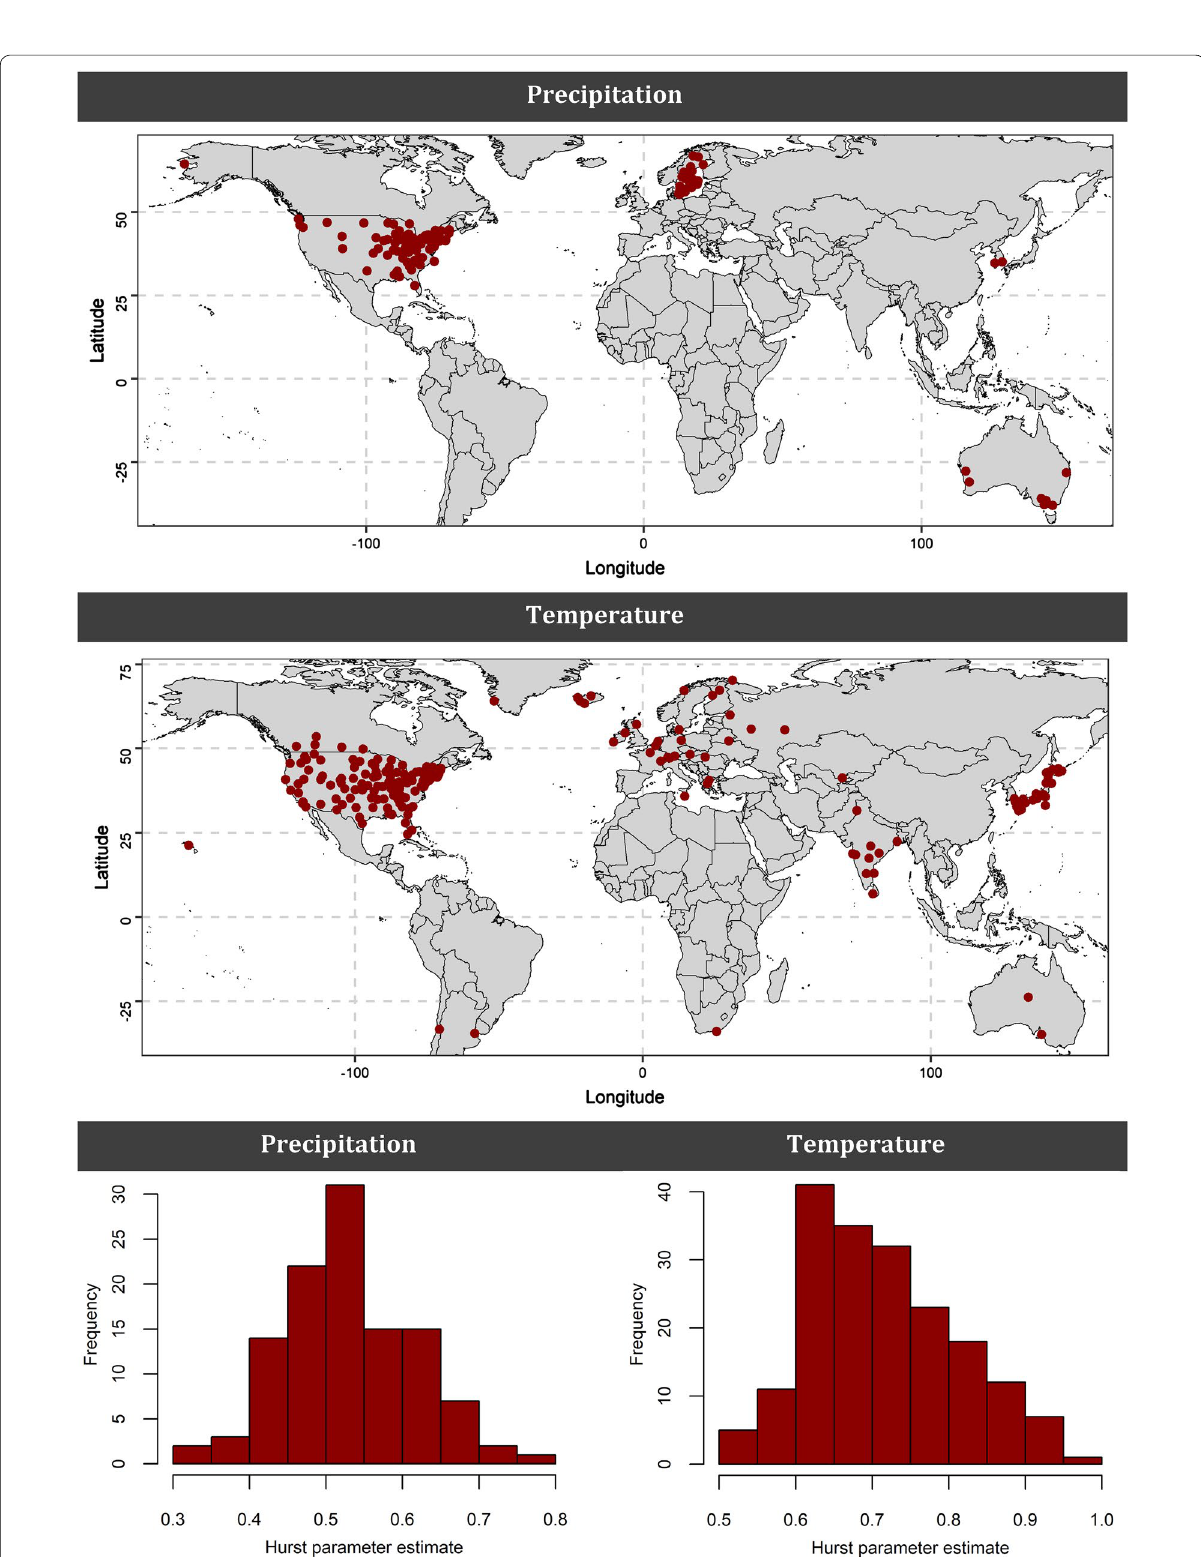
Fig. 1 Precipitation and temperature data from Peterson and Vose (1997) and Lawrimore et al. (2011)